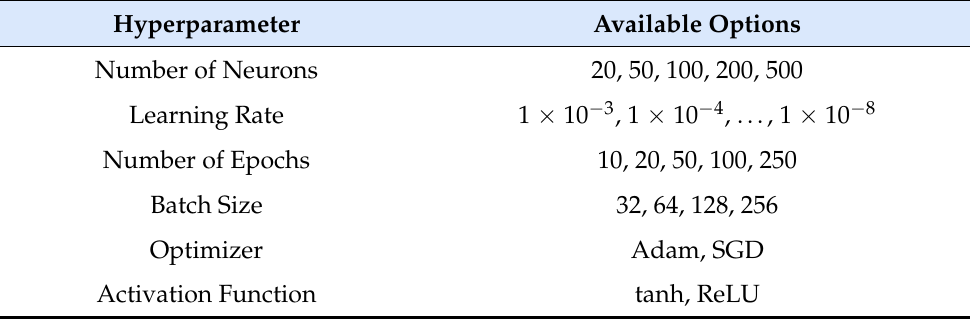
Table 1. Of note, the neural architecture search was performed using the data for each individual. Thus, each participant had a personalized set of hyperparameters. Table 1. Hyperparameters that were selected for optimization.